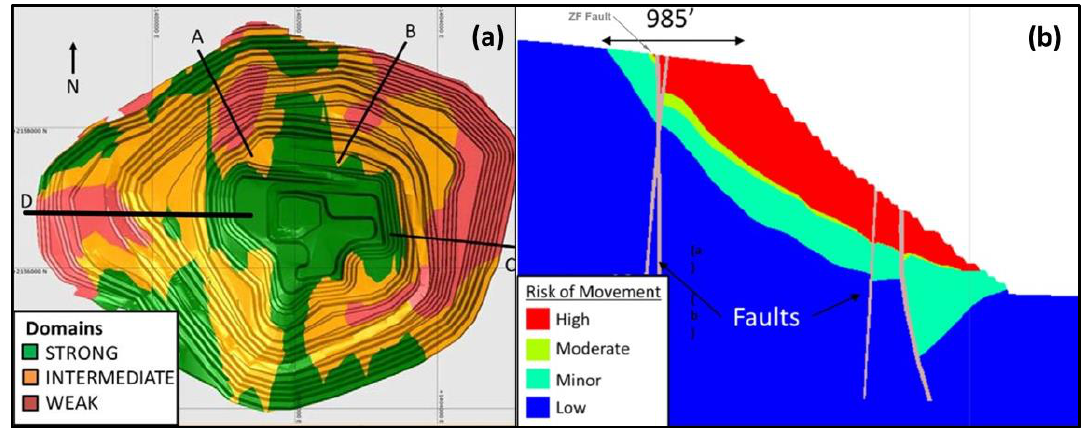
Figure 3. ( a ) Geotechnical domains in the open pit showing strong, intermediate, and weak rock strength areas. ( b ) Extent of pit wall failure risks along cross-section A using 25% weaker rock strength parameters. Sources: [15] (FEIS, Appendix K4.15; ( a ) Figure K4.15-14; ( b ) Figure K4.15-18b).